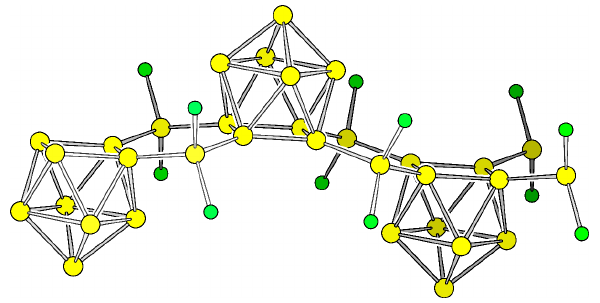
Figure 2. Cut-out of polymer P1 . Si and Cl are shown as yellow and green spheres, respectively. 3.2. Charged Molecules—The Stepwise Ligand Exchange in SiCl 4 to [Si 17 ] 12